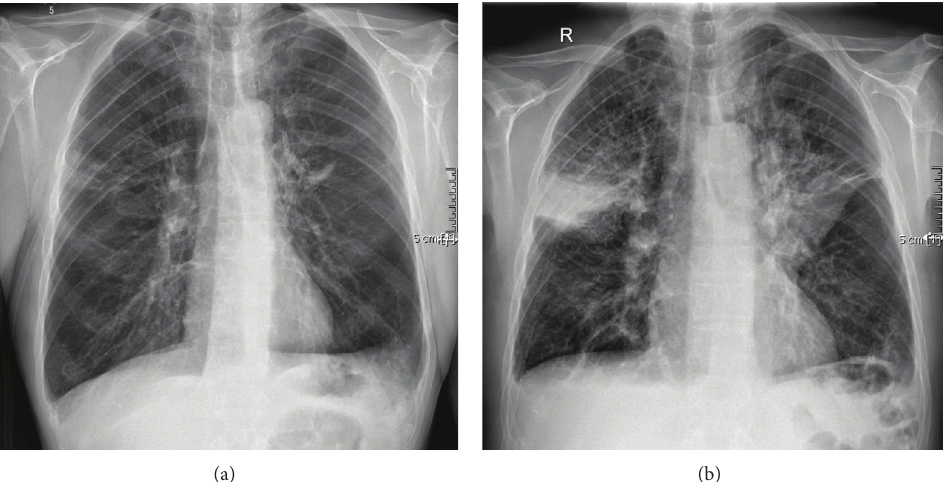
Figure 1: (a) Chest X-ray 4 weeks before the endoscopic lung volume reduction. (b) Chest X-ray 3 days after the endoscopic lung volume reduction shows atelectasis of both right and left upper lobe after endoscopic lung volume reduction.